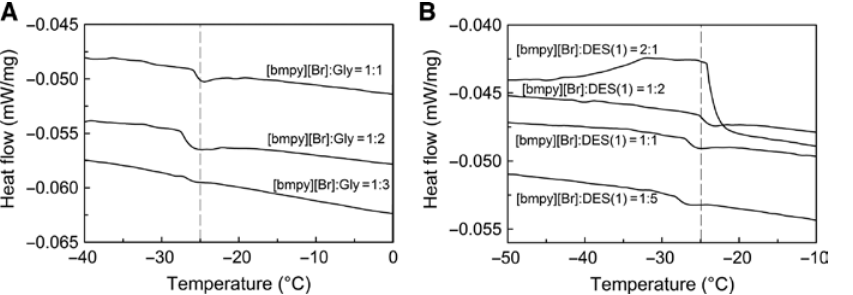
Figure 2: DSC curves of (A) BDES and (B) TDES taken from the second cooling cycle. The BDES are composed of [bmpy][Br] and glycerol in different molar ratios and the TDES is composed of [bmpy][Br] and DES(1) (ChCl:Gly = 1:2 molar ratio) in different mass ratios, as shown in the figure.